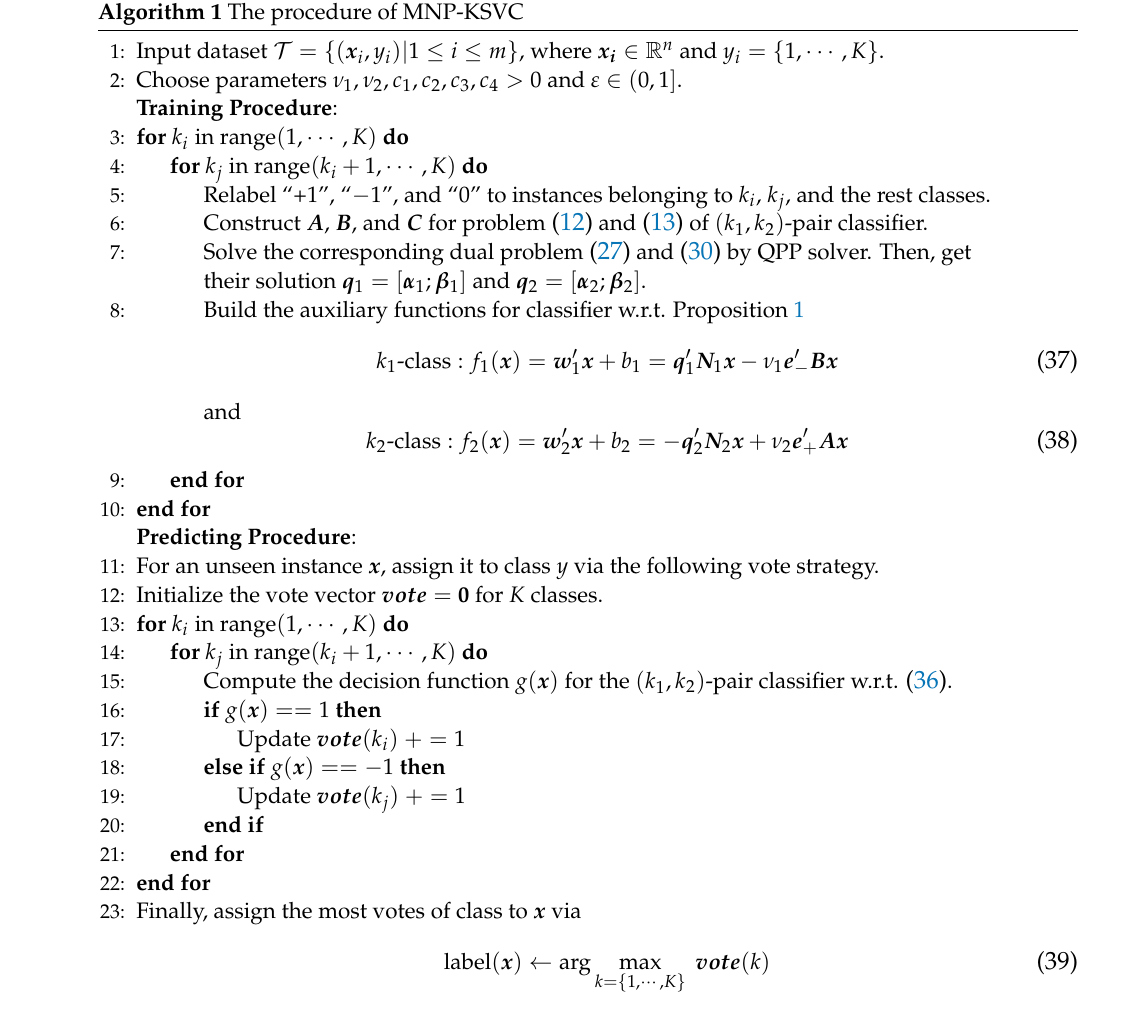
Algorithm 1 The procedure of